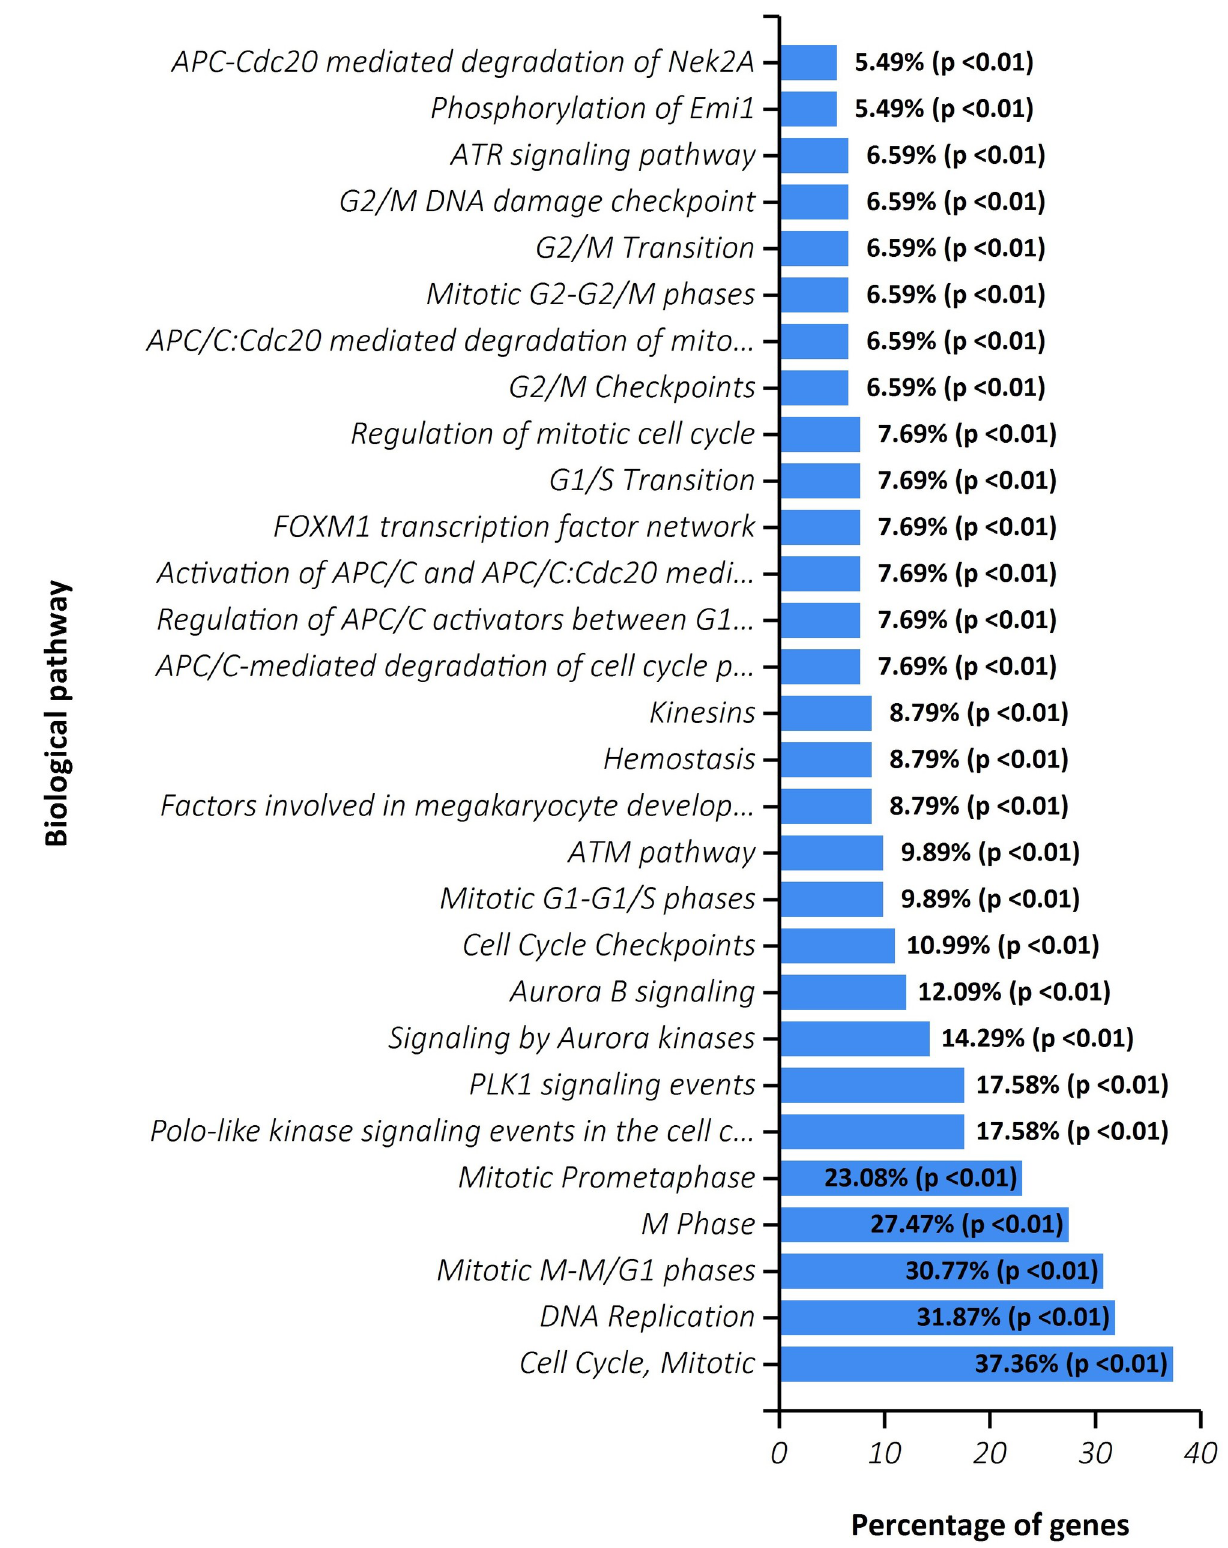
Fig 5. Pathway enrichment result of explored module around the seed gene HMMR.